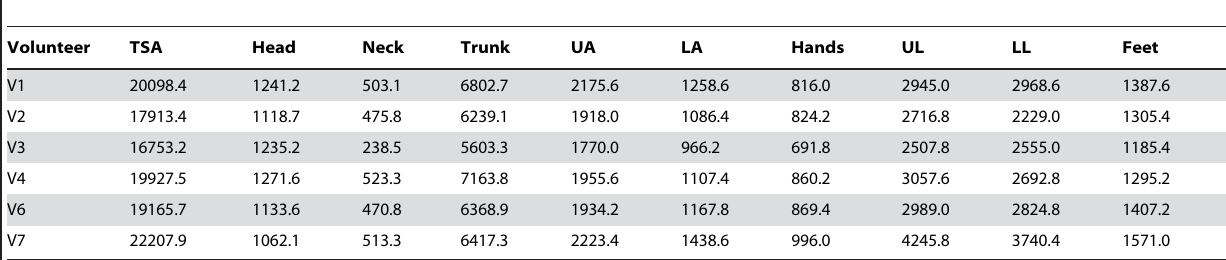
Table 2. Total and segment-specific surface areas for the study